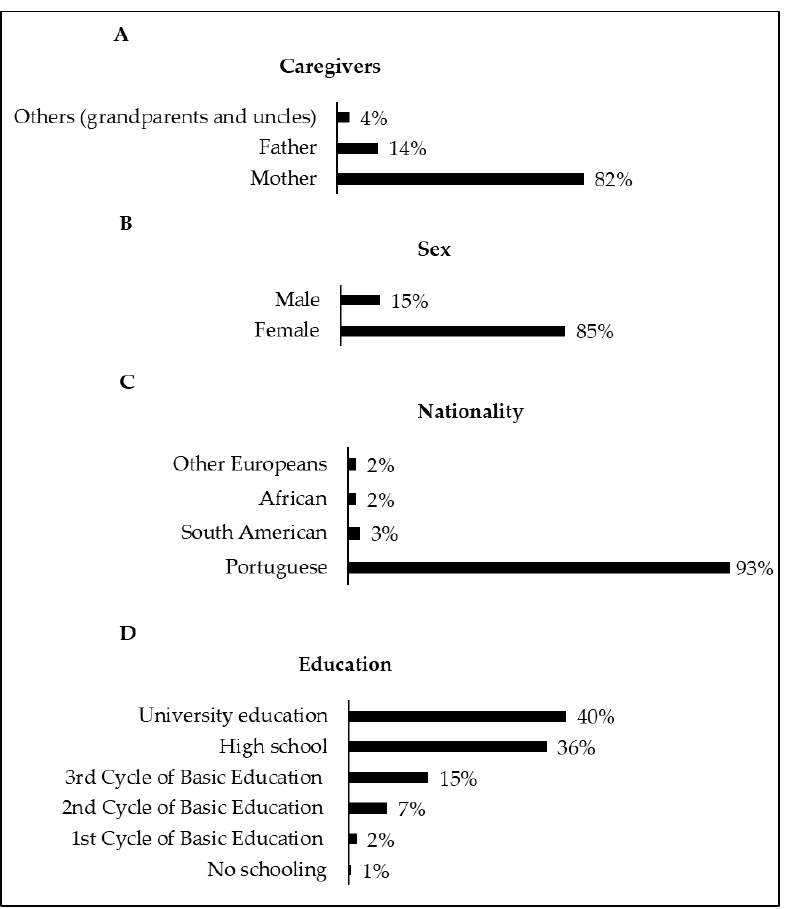
Figure 2. Caregivers who answered the questionnaire ( A ); sex of caregivers ( B ); nationality of caregivers ( C ); caregivers ’ education ( D ).